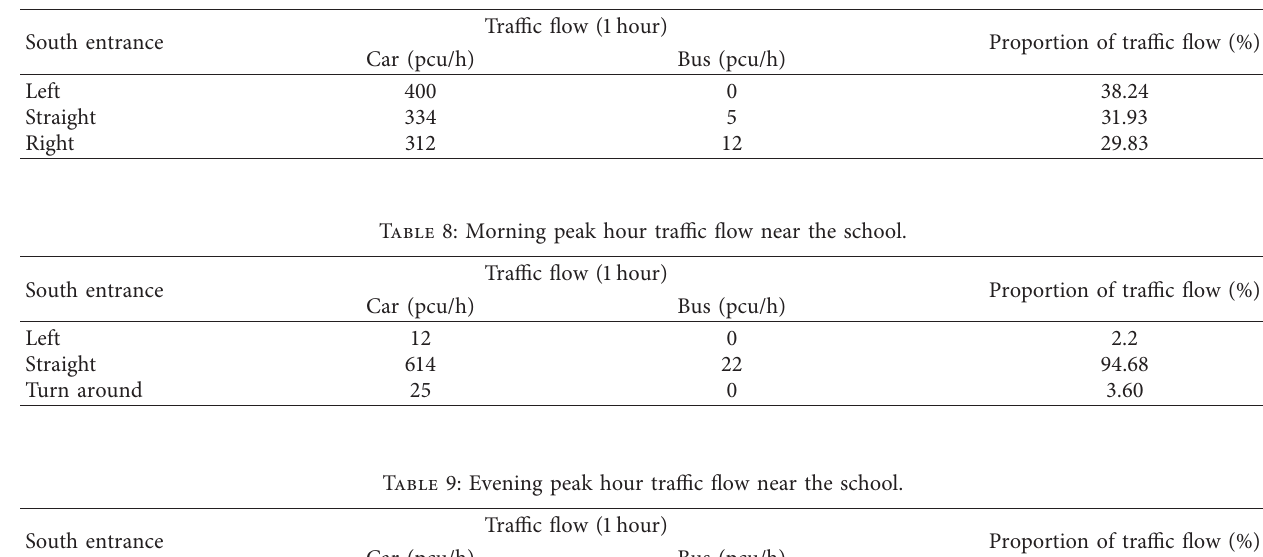
Table 7: Evening peak hour traffic flow at the intersection of Tieji Road and Heping Avenue.